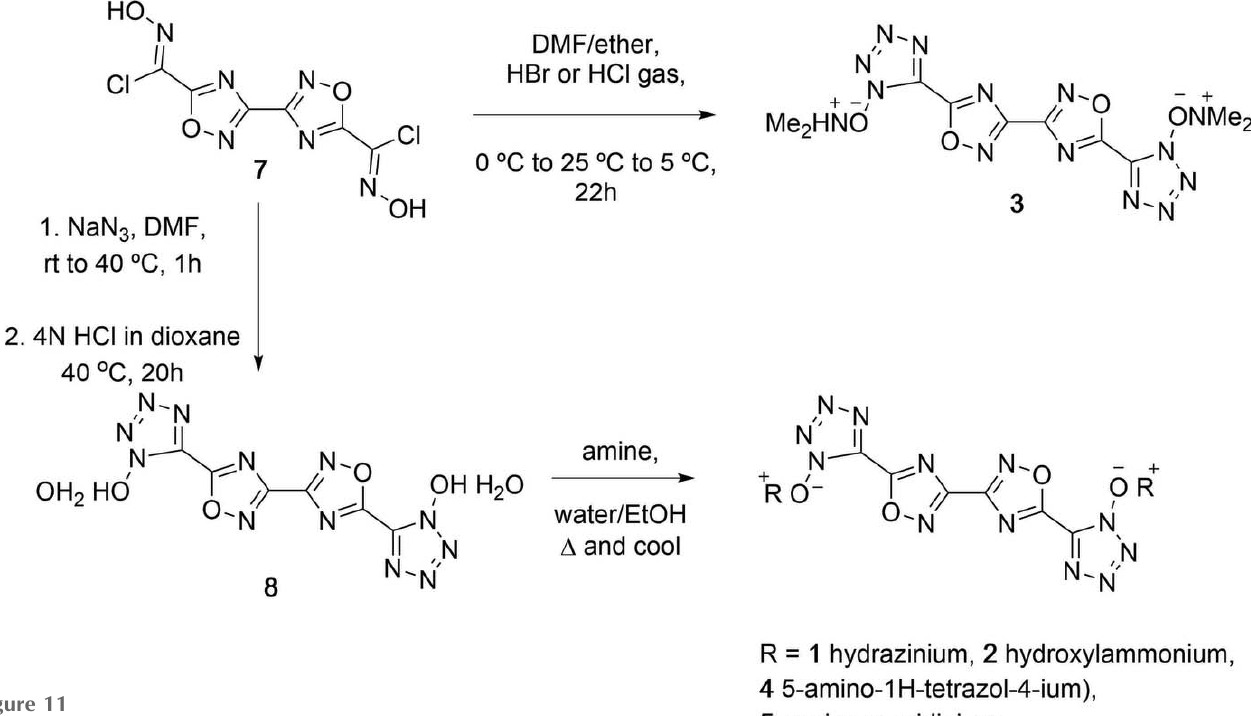
Figure 11 Scheme depicting synthesis pathways for the included